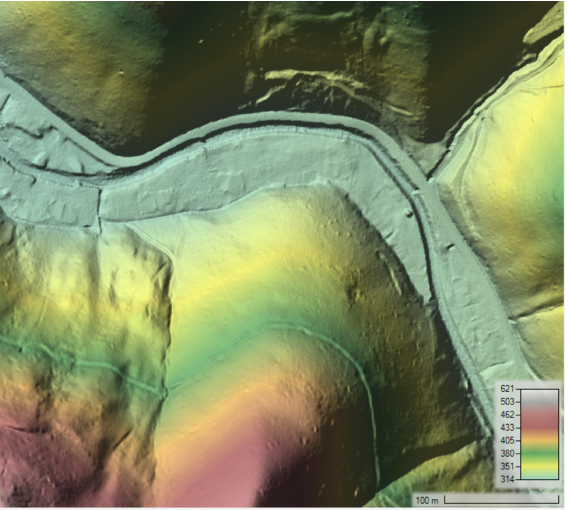
Figure 2. Digital Elevation Model of a small section of Guesses Fork Road in Hurley, Virginia. Rainfall data was acquired from the NOAA National Severe Storms Library (NSSL) Multi-Radar/Multi-Sensor System (MRMS) [21]. “The Multiple Radar Multiple Sensor system combines data streams from multiple radars, satellites, surface observations, upper air observations, lightning reports, rain gauges and numerical weather prediction